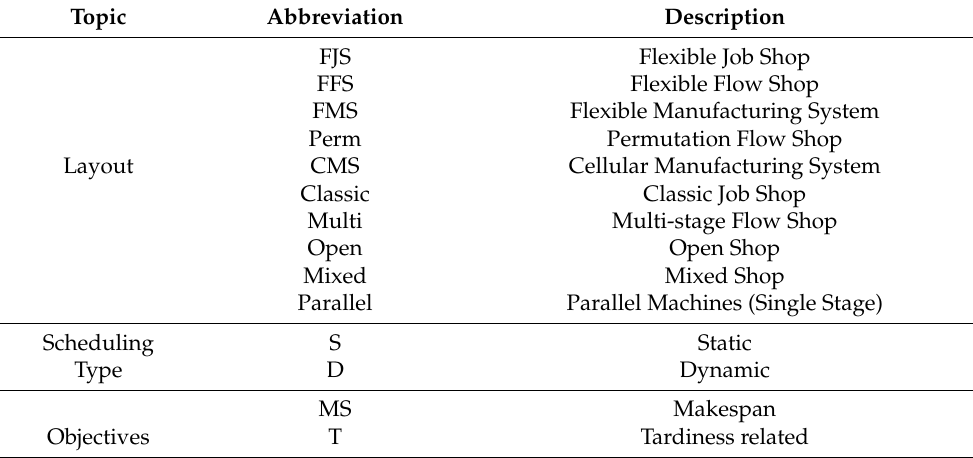
Table 5. The legend for tables and charts in this